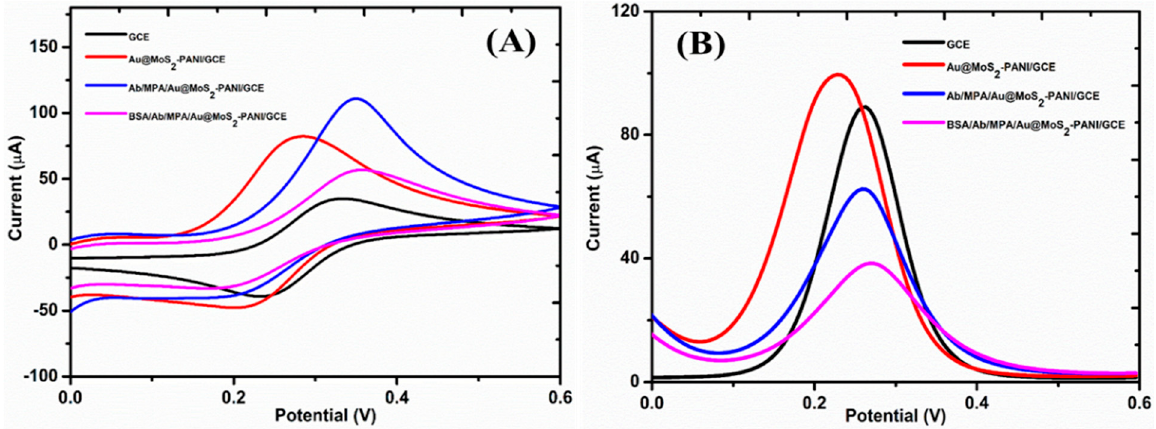
Figure 5. ( A , B ) The CV and DPV spectra of the immunosensor in 5 mM of [Fe(CN) 6 ] 3 − /4 − , 0.1 M of KCl, and 100 mM PBS buffer (pH = 7.4).